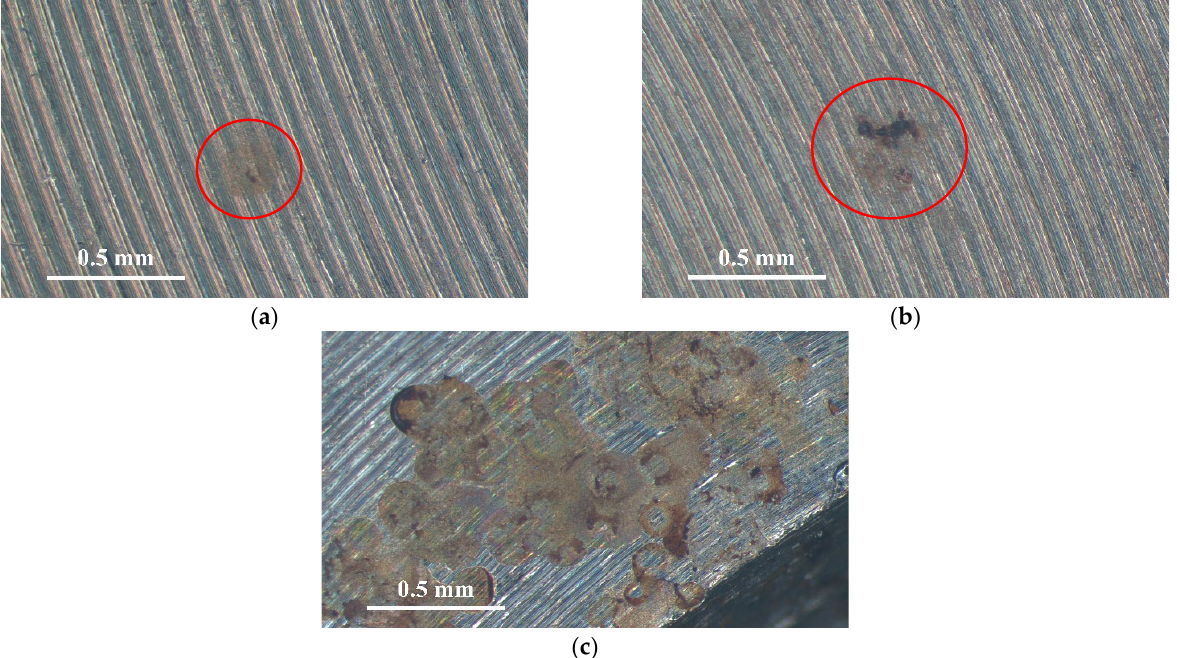
Figure 7. Macrographs of the corroded regions of those samples with a 1 g/m 2 chloride concentration at: ( a ) Relative humidity = 45%, ( b ) relative humidity = 55%, and ( c ) relative humidity = 70%.